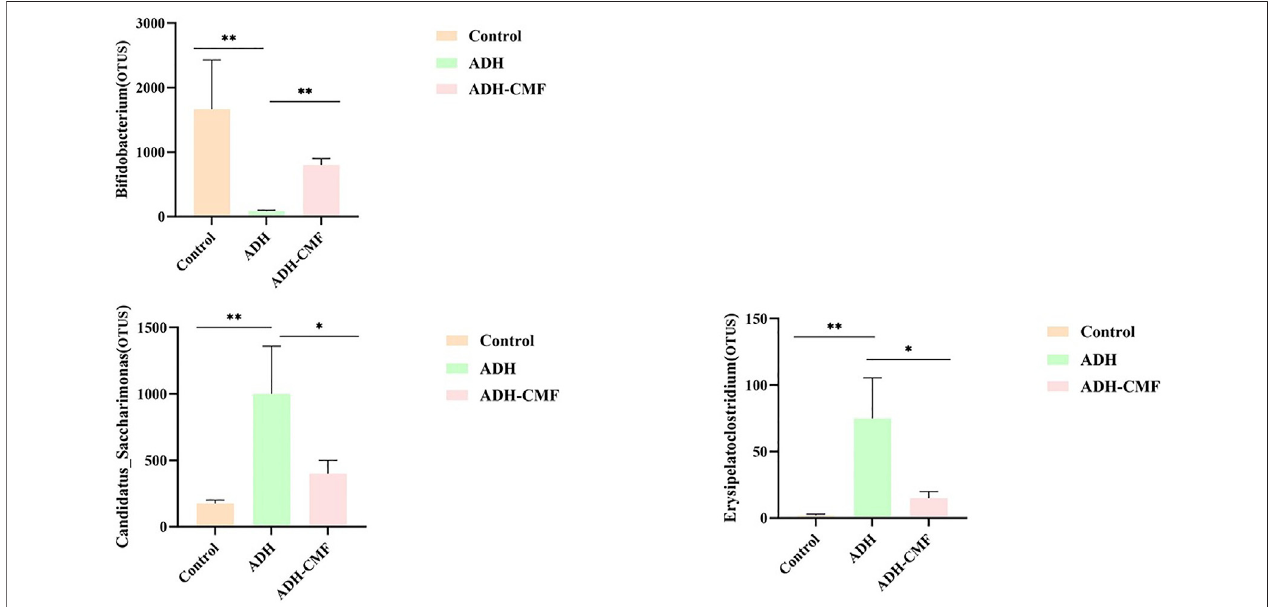
FIGURE 8 | The differential analysis of intestinal fl ora at the genus level ** p < 0.001; * p < 0.01.